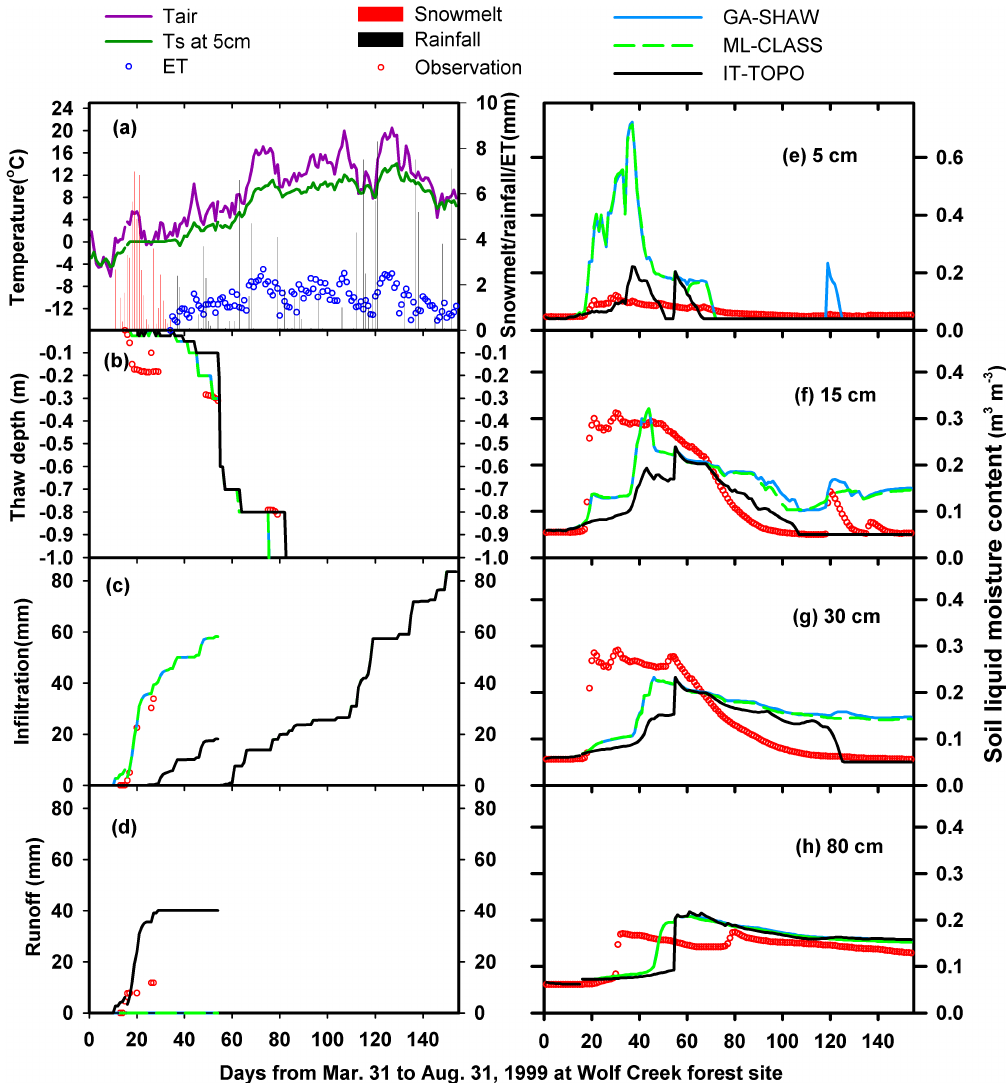
Fig. 6. Surface forcing variables (a) , observed and simulated ground thaw depths (b) , cumulative infiltration (c) and runoff (d) at three thawing stages, and liquid soil water content at the monitoring depths ( e , f , g and h ) at Wolf Creek forest